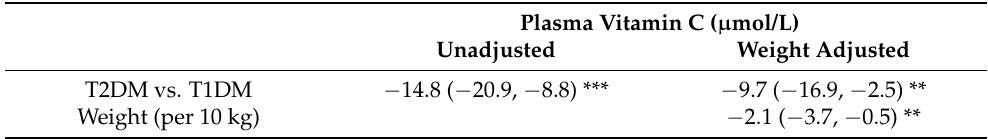
Table 5. Multivariable analysis of predictors of vitamin C